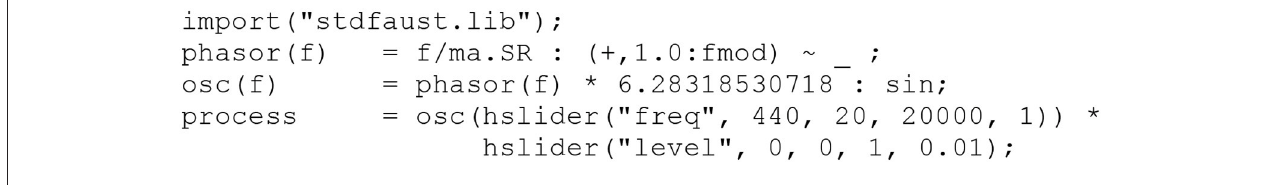
FIGURE 9 | A program in Faust to generate a sine